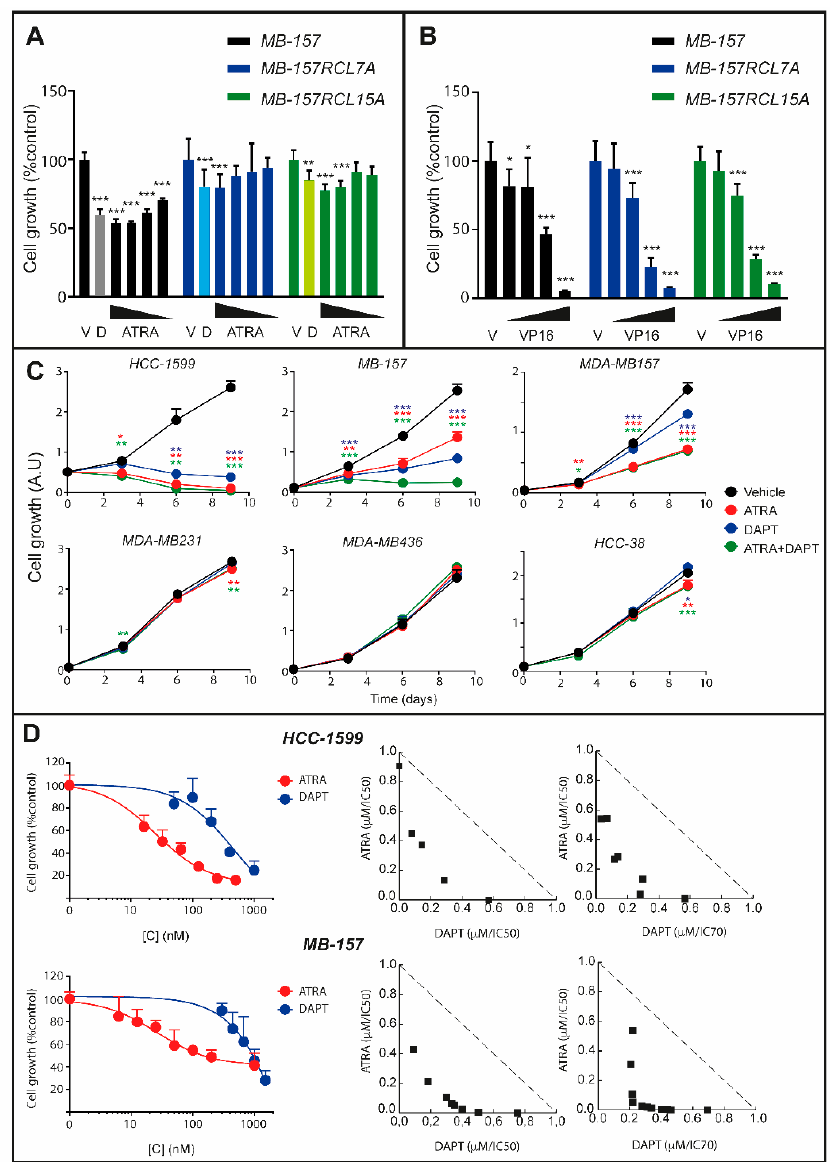
Figure 3. E ff ects of ATRA and DAPT alone or in combination on the growth of selected TNBC cell lines. ( A ) Parental MB-157 and DAPT-resistant MB-157RCL7 or MB-157RCL15 cells were treated with vehicle (DMSO), DAPT (1 µ M) and decreasing concentrations of ATRA (1.0 µ M, 0.3 µ M, 0.1 µ M and 0.03 µ M) for 6 days. Cell growth was determined with the sulforhodamine assay. Each column represents the Mean ± SD of 6 replicate cultures. Two-way ANOVA followed by a Dunnett’s test (Prism Path 8) was used for the comparison of each treatment to the corresponding vehicle treated control. *** Significantly di ff erent ( p < 0.001); ** Significantly di ff erent ( p < 0.01). The anti-proliferative e ff ect of DAPT in MB-157 parental cells (grey column) is significantly higher than in resistant MB-157RCL7 (light blue column) and MB-157RCL15 (light green column) cells ( p < 0.01, Dunnett’s test, Prism Path 8). ( B ) Parental MB-157 and DAPT-resistant MB-157RCL7 and MB-157RCL15 cells were treated with decreasing concentrations (16.0 µ M, 3.2 µ M, 0.6 µ M and 0.1 µ M) of VP16 for 3 days. Cell growth was determined with the sulforhodamine assay. Each column represents the Mean ± SD of 6 replicate cultures. Two-way ANOVA followed by a Dunnett’s test (Prism Path 8) was used for the comparison of each concentration of VP16 to the corresponding vehicle treated control. *** Significantly different ( p < 0.001); * Significantly different ( p < 0.05). ( C ) The indicated cell lines were treated with ATRA (1 µM), DAPT (1 µM) or the ATRA+DAPT combination for 3, 6 and 9 days, as indicated. Cell growth was determined with the Sulforhodamine assay ( MDA-MB157 and MB-157 cells) or the CellTiter-Glo-Luminescent-Cell-Viability assay ( HCC-1599 cells). A.U. = Arbitrary Units.